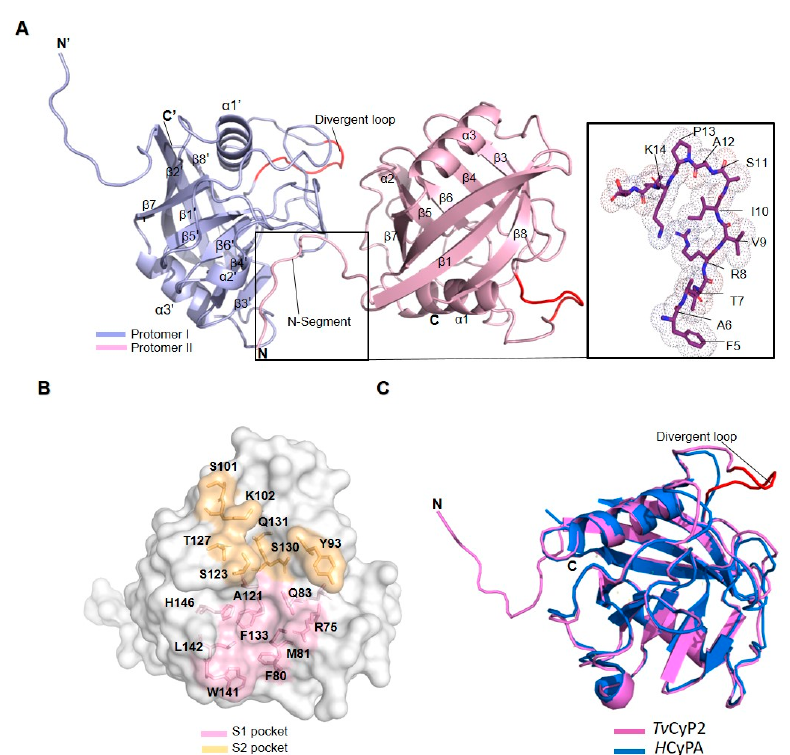
Figure 3. ( A ) The X-ray crystal structure of Tv CyP2 has a typical canonical cyclophilin fold and contains 3 α -helices and 8 β -strand secondary elements, with the divergent loop from residues 61–67 in red. The N-terminal segment is associated with a neighboring Tv CyP2, which is highlighted in the box with the conformation of the N-terminal F5 to K14 shown in the right box. ( B ) Surface structure of Tv CyP2 showed the distribution of both active-site and S2 pocket residues in pink and orange, respectively. ( C ) Structural comparison by superimposing the Tv CyP2 structure in magenta with h CypA in blue, with the divergent loop shown in red.